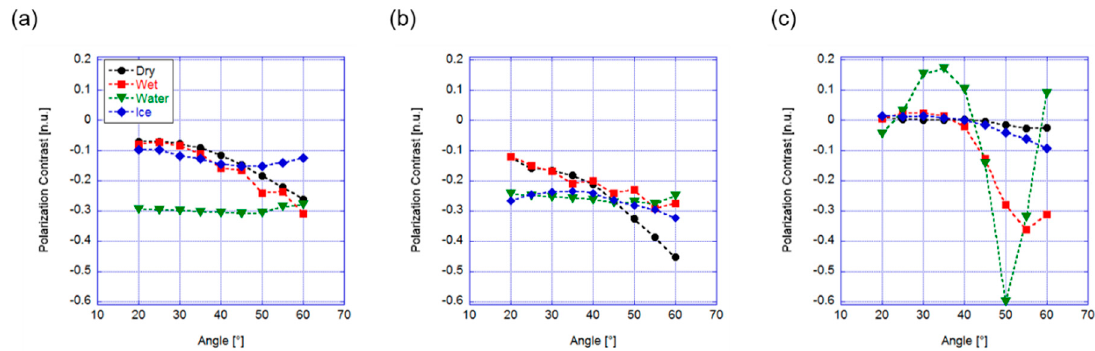
Figure 2. θ –2 θ configuration. Polarization contrast versus incidence angle for ( a ) unpolarized, ( b ) horizontally and ( c ) vertically polarized incident light.